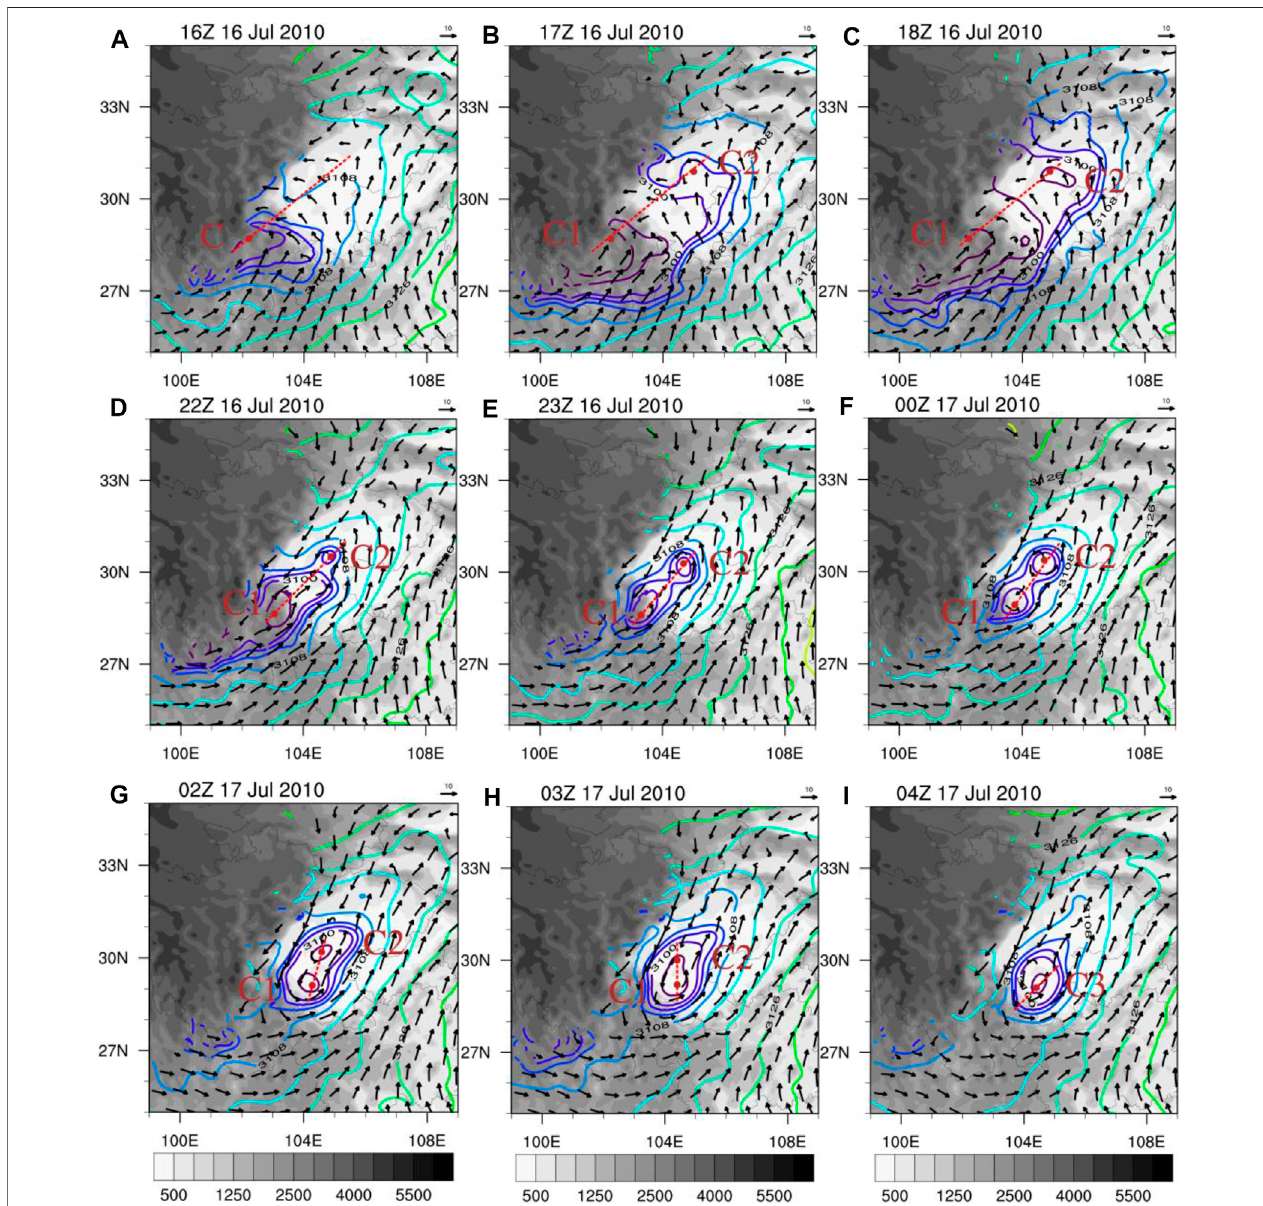
FIGURE 7| Modeling simulated 700hPa geopotential height (gpm, contours), wind fi eld (m s − 1 , arrows), and terrain height (m, shaded) from the control simulation (CTL) experiment inside Domain 02 at (A) 16:00 UTC July 16, (B) 17:00 UTC July 16, (C) 18:00 UTC July 16, (D) 22:00 UTC July 16, (E) 23:00 UTC July 16, (F) 00:00 UTC July 17, (G) 02:00 UTC July 17, (H) 03:00UTC July 17, and (i) 04:00 UTCJuly 17. The red dots denote the centersofSWVs. The red lines indicate the transects of the cross sections in Figure 8